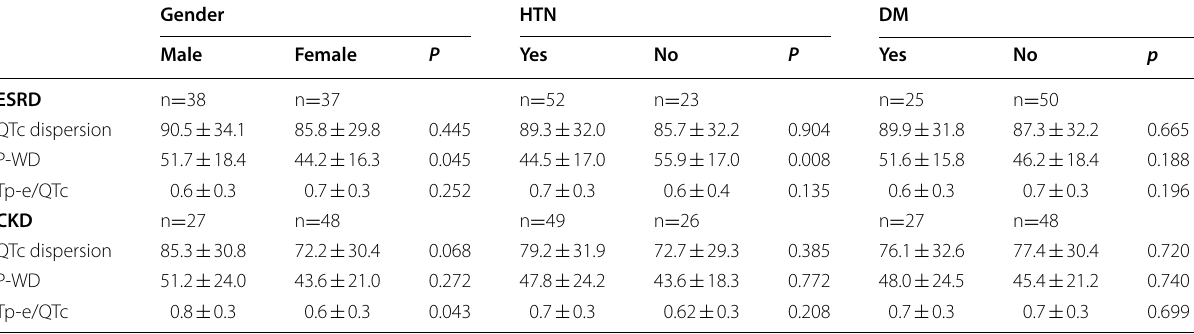
P-WD, P wave dispersion; QTc, Corrected QT interval; Tp-e, T wave peak to end interval